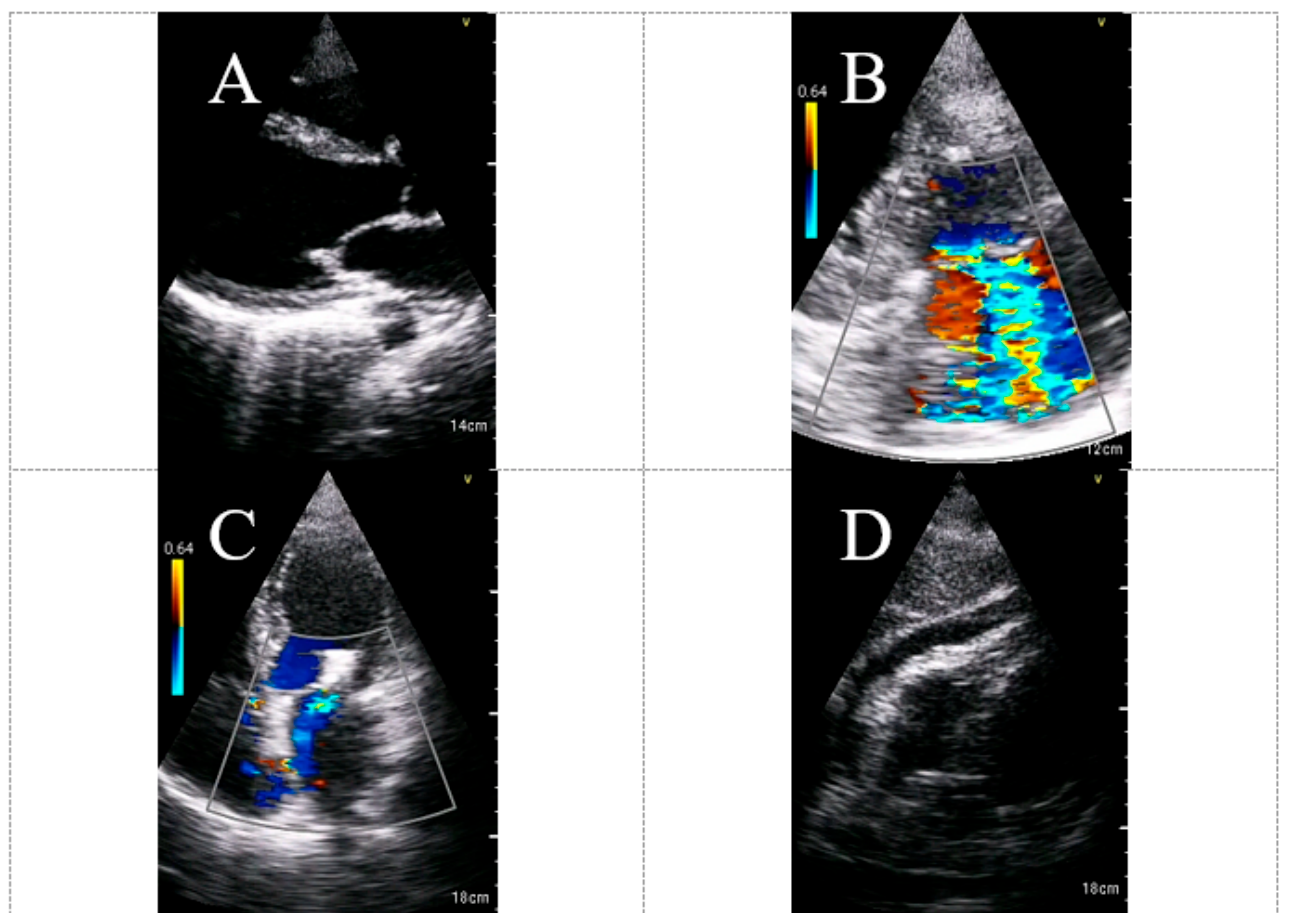
Figure 5. HUD acquired echocardiographic images in COVID-19 patients demonstrating abnormal findings: Dilated LV with reduced systolic function ( A ), severe MR ( B ), status post MitraClip transcatheter mitral valve repair ( C ) and pericardial effusion (subcostal view) ( D ). The imaged were acquired using the Vscan Extend with the Dual Probe, General Electric. Abbreviations: HUD, hand-held ultrasound device; LV, left ventricle; MR, mitral regurgitation.